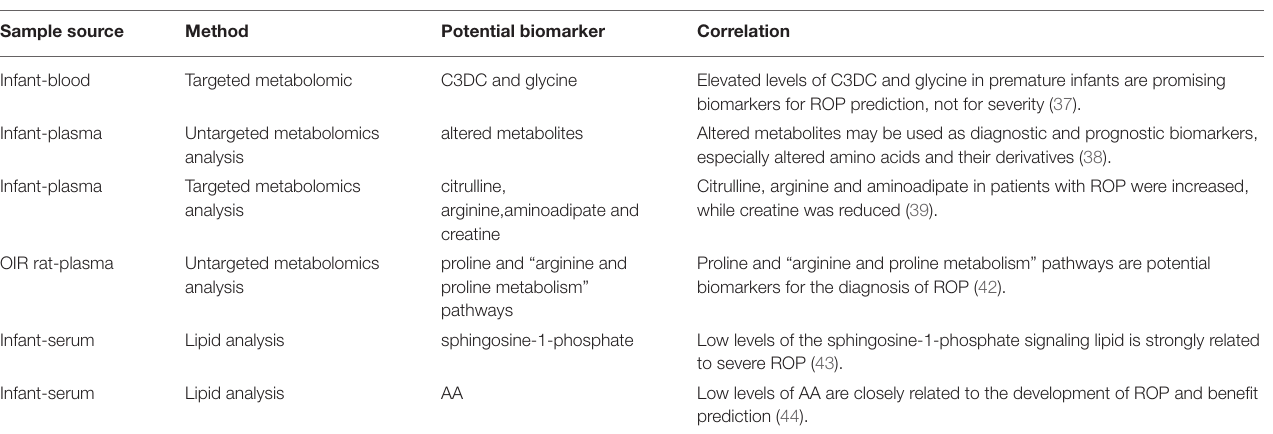
TABLE 1 | Metabolites as potential biomarkers for ROP